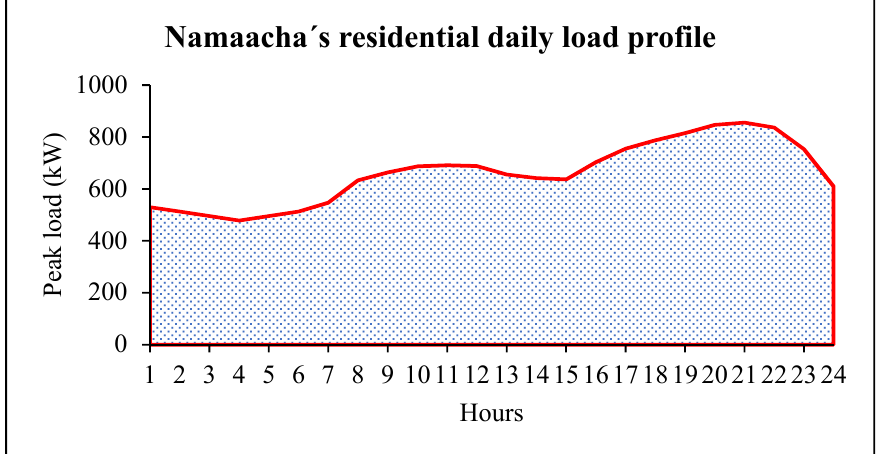
Figure 4. Namaacha ′ s typical residential daily load profile on 15 January. Courtesy of Mozambique Power Company (EDM) [35].